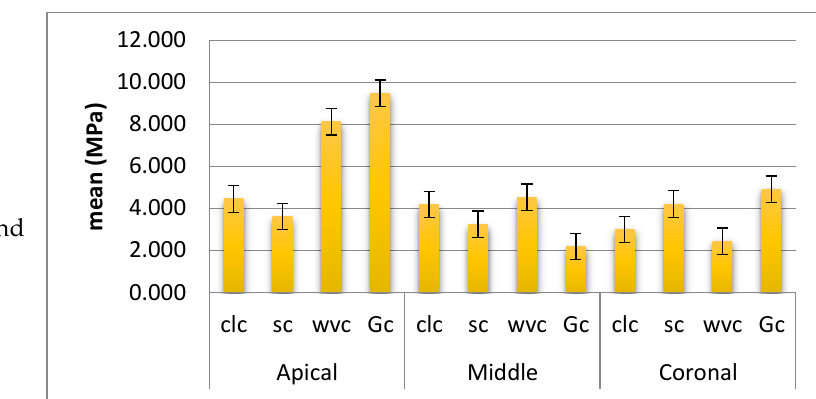
Figure (2): The average bond strength values ( in MPa).